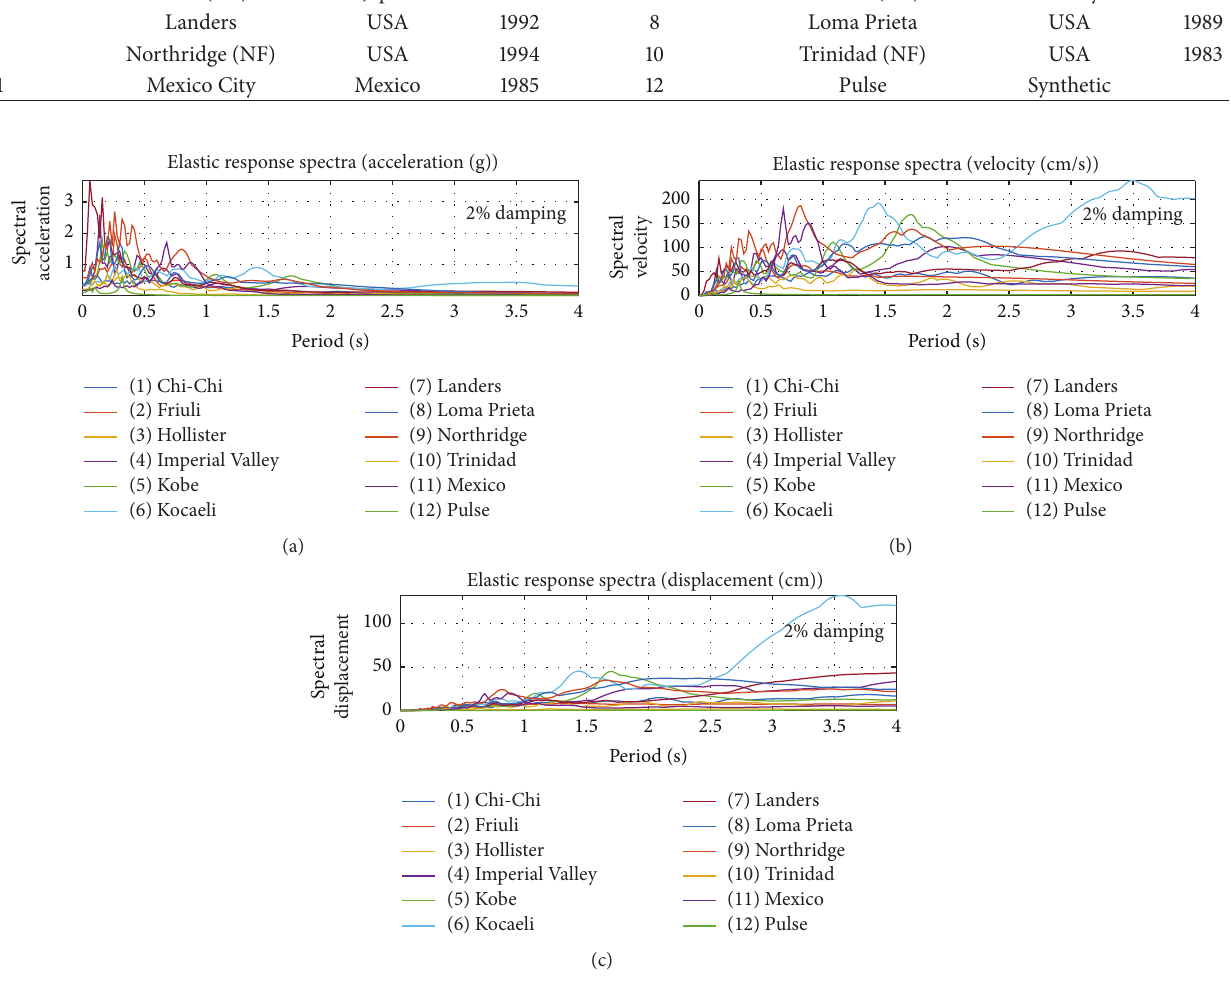
Figure 2: Elastic response spectra of the utilized ground motions: (a) acceleration; (b) velocity; (c)